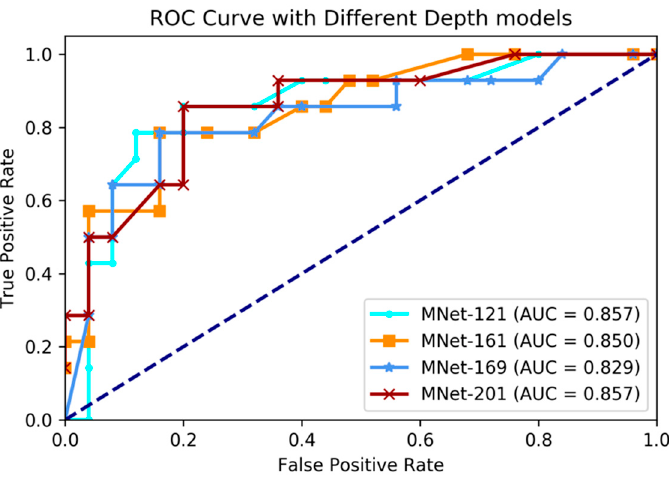
Figure 3. Comparing receiver operating characteristic (ROC) curve of different depth layer models on IDH genotype prediction experiments. AUC: area under the curve.